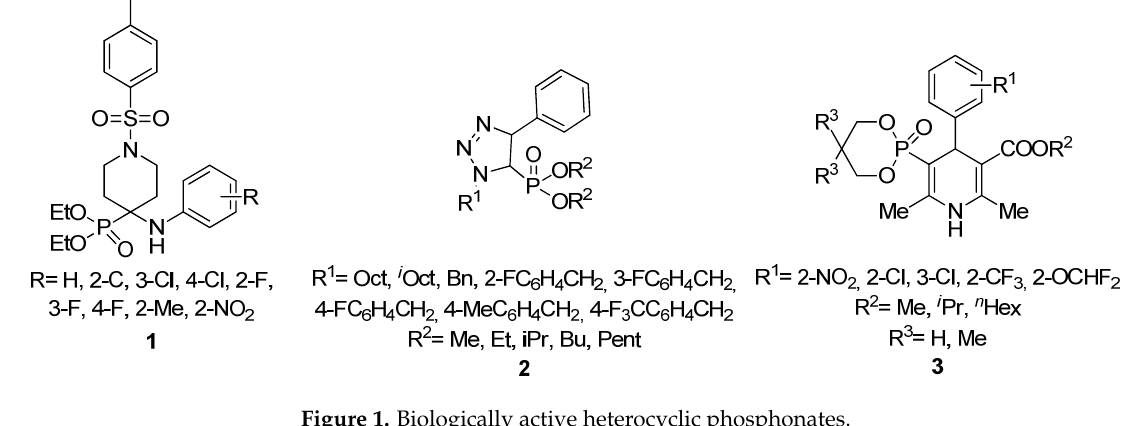
Figure 1. Biologically active heterocyclic phosphonates.